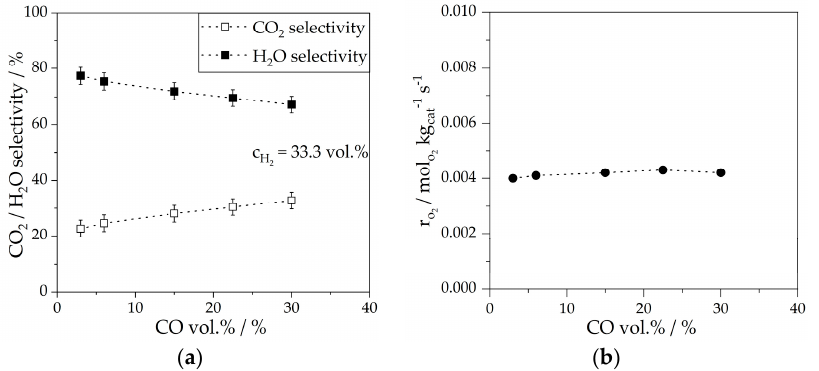
Figure 7. ( a ) Selectivity of O 2 products for different CO concentrations. ( b ) Oxygen reaction rate for different CO concentrations. Conditions: p = 20 bar; T = 215 °C; 𝑉(cid:4662) total = 15.9 L/h (NTP); p CO+N2 = 13.2